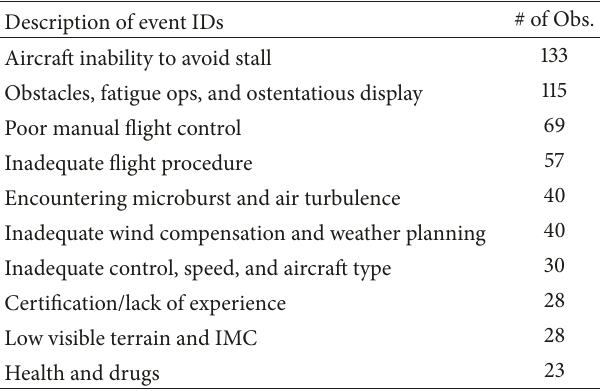
Table 3: Chronology of top ten events’